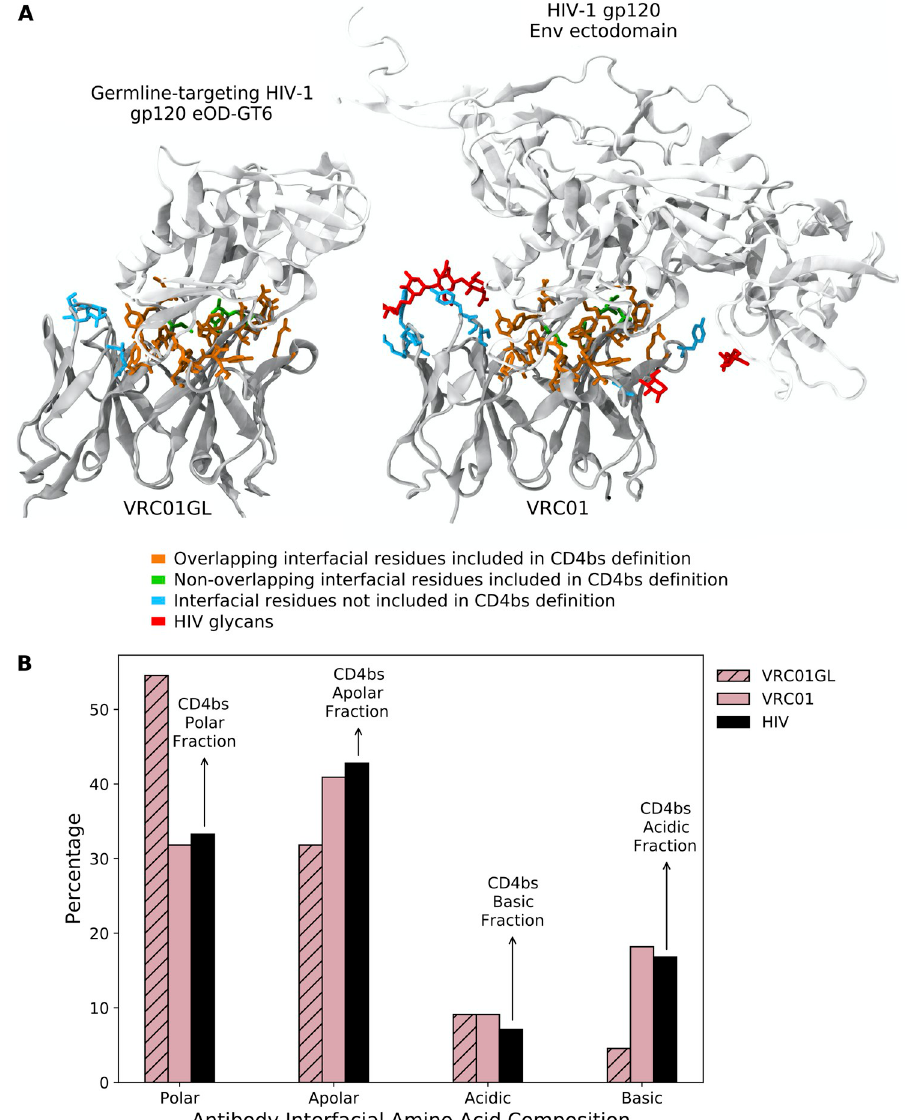
Fig 6. Definition of interfacial BCR residues used to characterize AM simulations. (A) VMD snapshots of (left) VRC01GL and (right) VRC01, in complex with HIV-based Ags. Ags are colored in silver and Abs in gray. Residues included in the in silico CD4bs interfacial residue definition are colored orange if overlapping between the two Abs and colored green otherwise, and interfacial residues excluded from the definition due to contact or alignment with HIV glycans (red) are colored cyan. (B) Interfacial amino acid compositions for VRC01GL and VRC01 are shown by hatched and solid pink bars, respectively, using the residues defined in orange/green in (A), which mimic the biological trends shown in Fig 3. For each amino acid type, the Abs’ target interfacial fraction in the CD4bs of HIV is indicated by a black bar (note that the Abs’ acidic interfacial compositions evolve to match the basic interfacial composition of the CD4bs, and vice